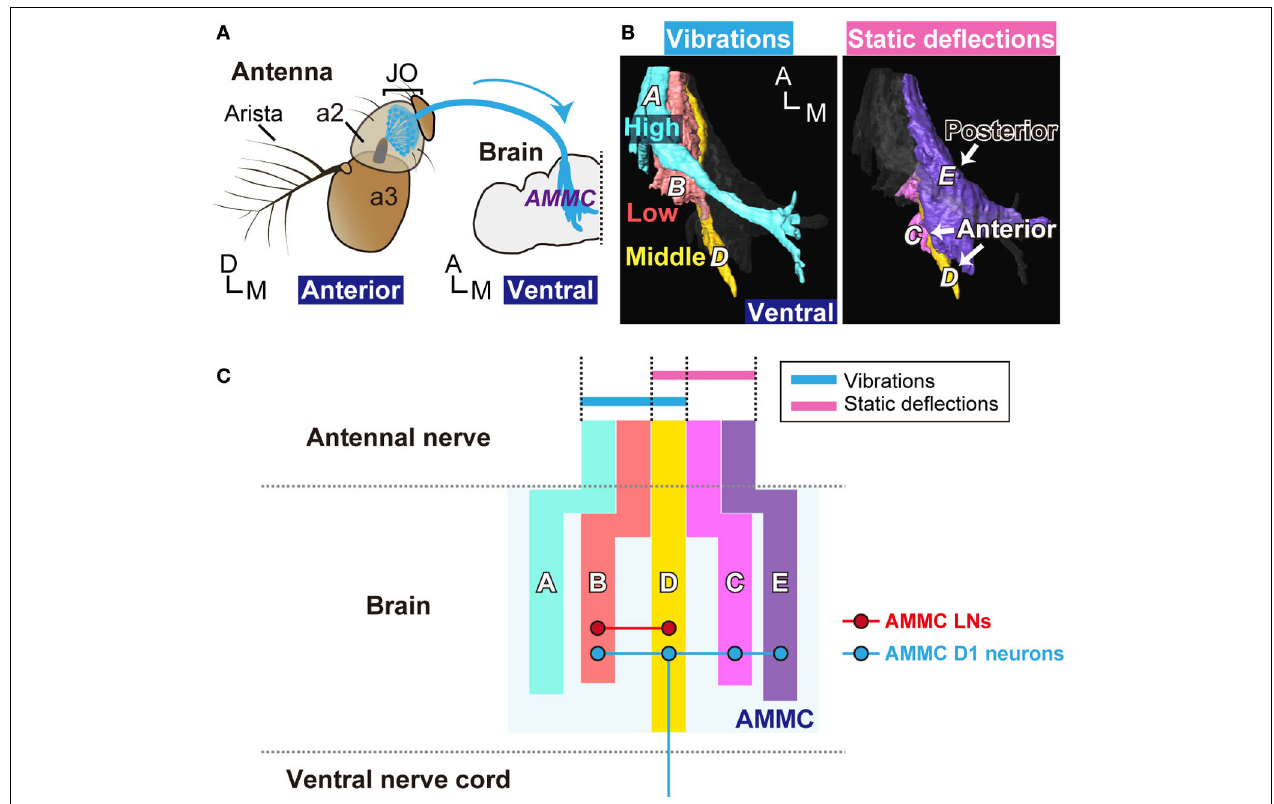
FIGURE 6 | Neural pathway from Johnston’s organ to the brain. (A) Antennal ear of the fly. Vibrations of the antennal receiver, the arista, and the antennal third segment (a3), are transmitted to JO neurons (blue) in the antennal second segment (a2). JO neurons project their axons to the antennal mechanosensory and motor center (AMMC) in the brain. Modified from Kamikouchi et al. (2006). (B) Axonal projections of JO neurons in the brain. Left panel; Zones A (light blue), B (red), and D (yellow), which comprise the primary centers for antennal vibrations (movements), selectively respond to high-, low-, and middle-frequencies, respectively. Right panel; Zones C (pink), D (yellow), and E (purple), which